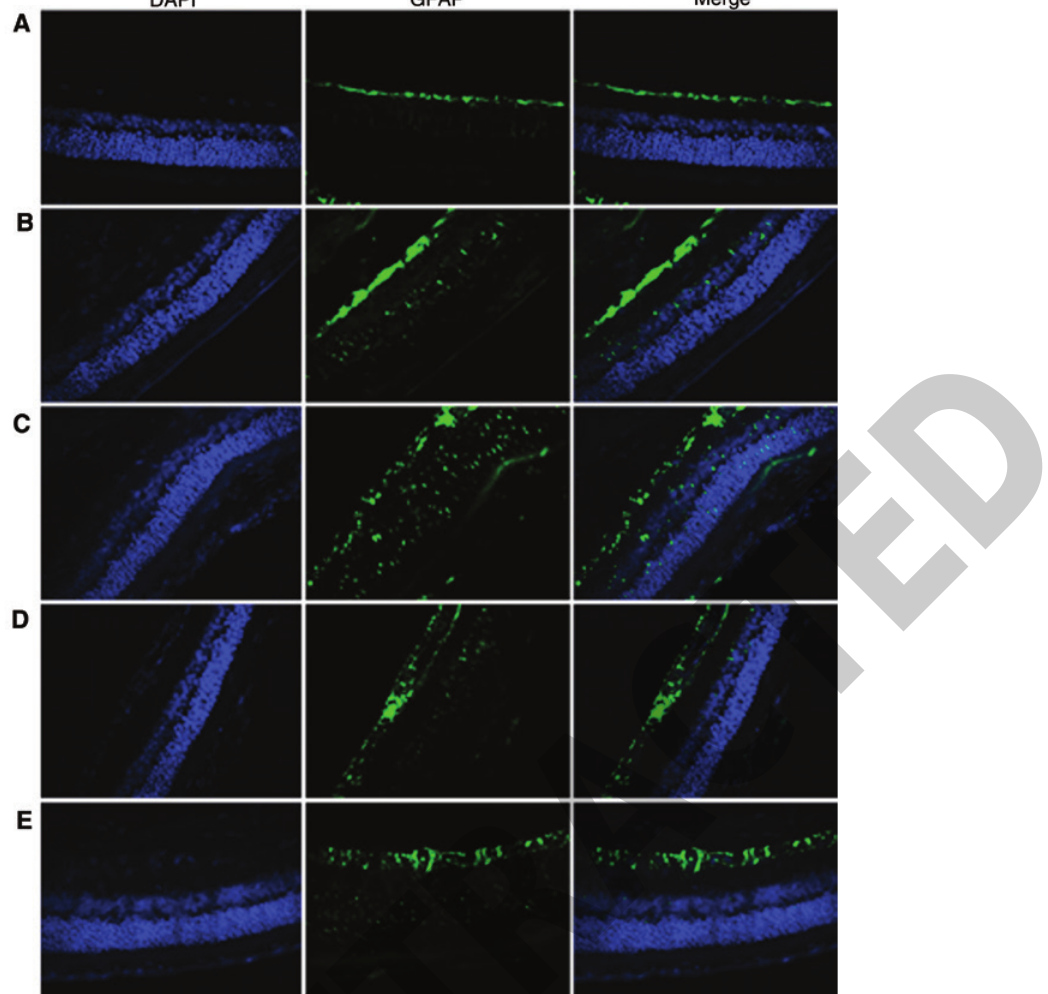
Figure 7: Immunohistochemical evaluation of gliosis marker glial fibrillary acidic protein (GFAP). Representative retinal sections of control- (A), ADan-red- (B), ADan-oxi- (C), A β 1-40- (D), and A β 1-42- (E) injected eyes that were labeled with GFAP (green). Nuclei are labeled with DAPI (blue). Scale bar: 50 μ